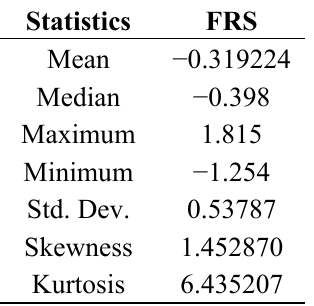
Table 2. FRS Descriptive